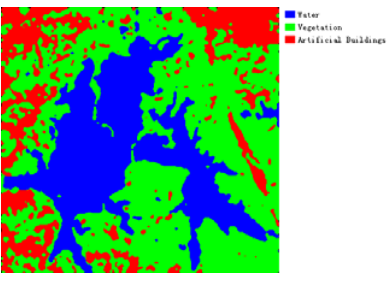
Figure 7. The classification result of SAR